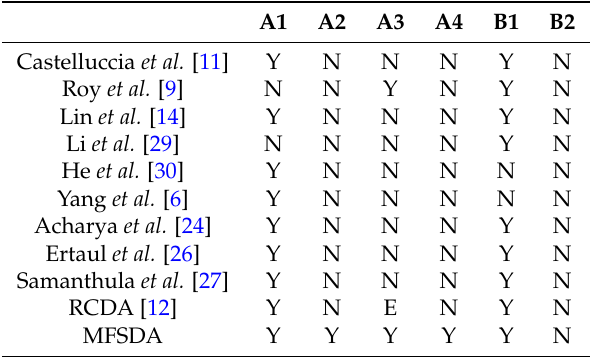
Table 5. Comparison of SDA schemes on